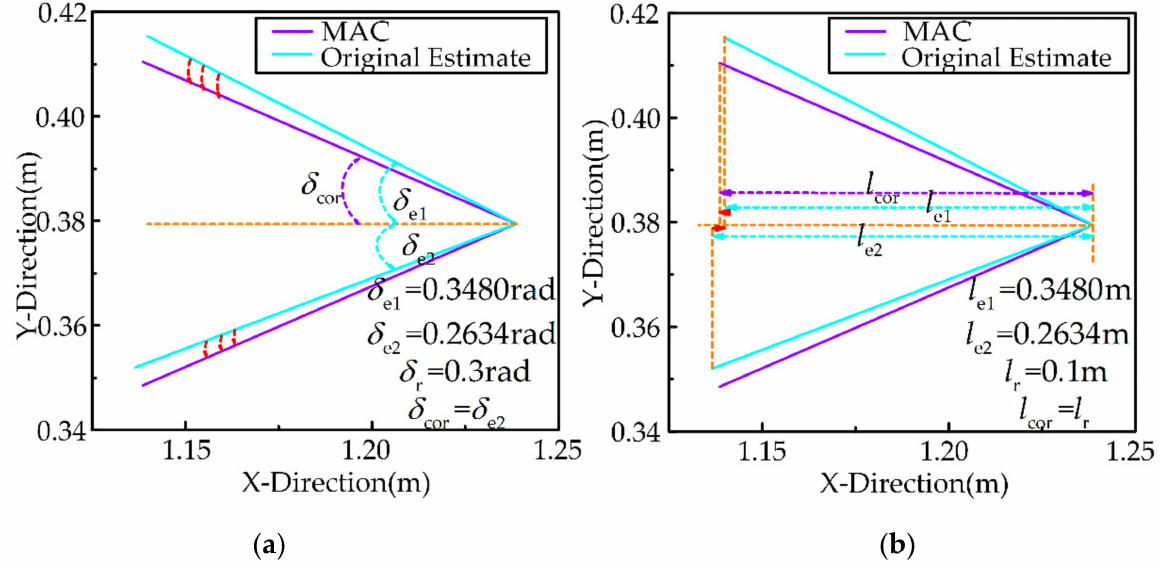
Figure 10. Simulation results of MAC. ( a ) simulation results of MAC (angle) and ( b ) simulation results of MAC